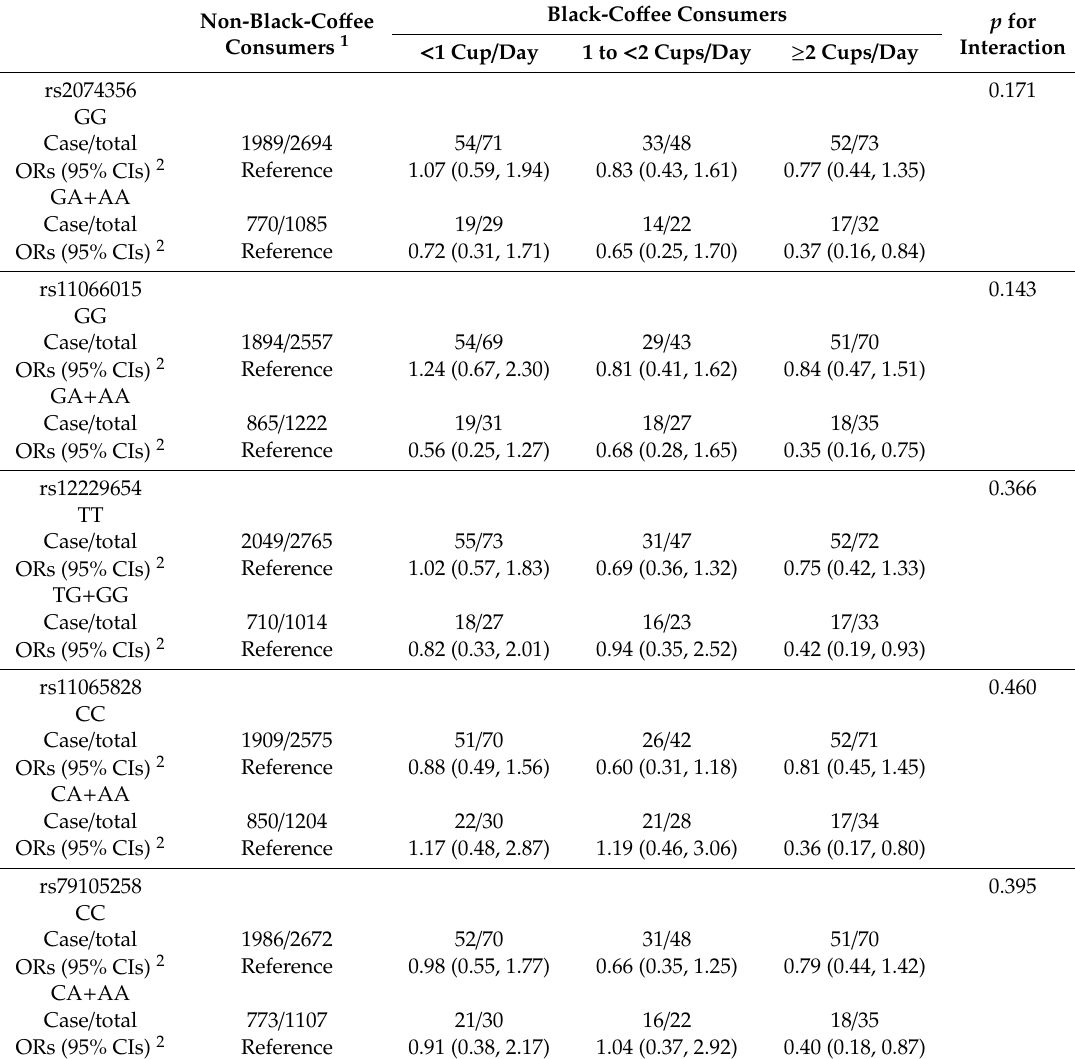
Table 7. Multivariate-adjusted ORs and 95% CIs for the risk of prediabetes and type 2 diabetes combined by 5 co ff ee-related SNPs according to black co ff ee